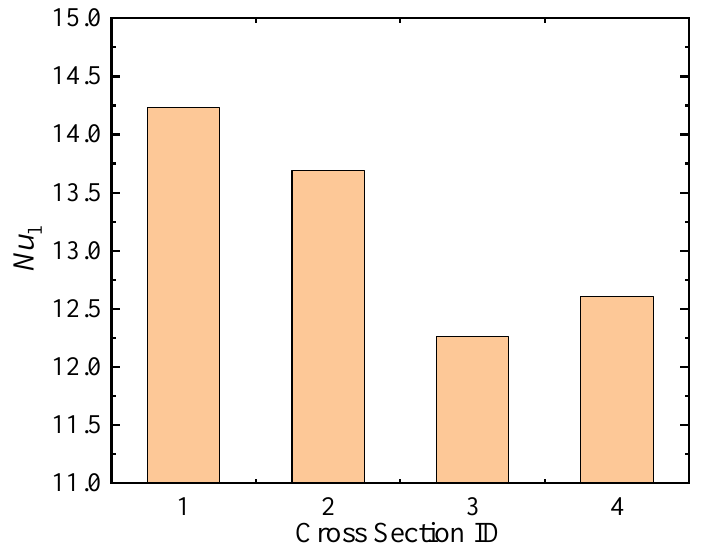
Energies 2023 , 16 , x FOR PEER REVIEW 15 of 33